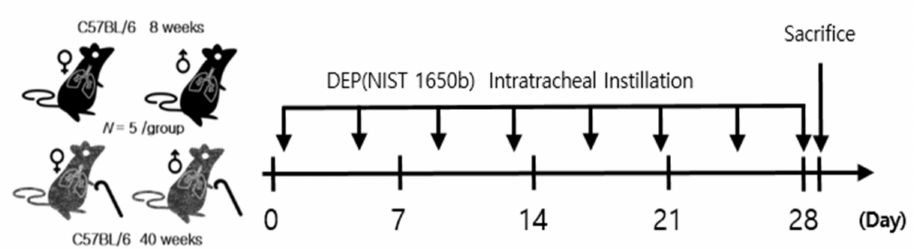
Figure 1. Schematic illustration of the experimental design. Mice were intratracheally instilled with DEP (diesel exhaust particle). The control group was treated with 50 µ L ultrapure water. (n = 5 per group).